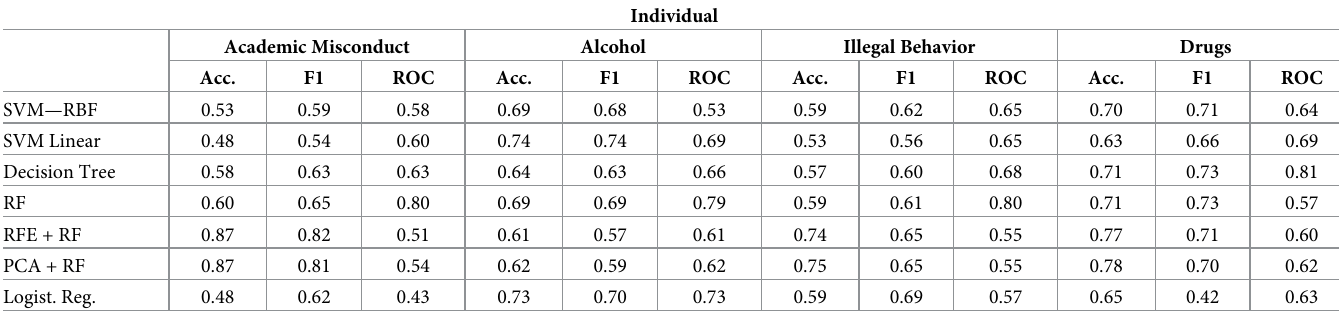
Table 4. Performance metrics across models and behaviors for individual FoMO